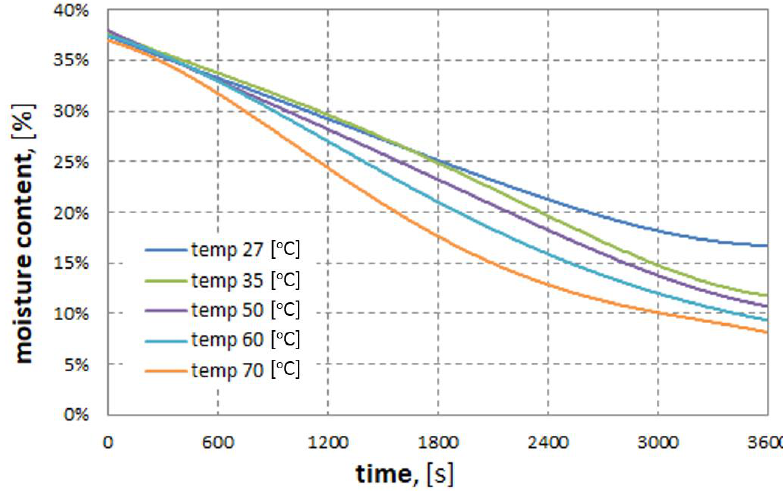
Figure 11. Influence of air temperature on the drying process in the 3D installation. Grain size was 0–8 mm of Bełchatów lignite.